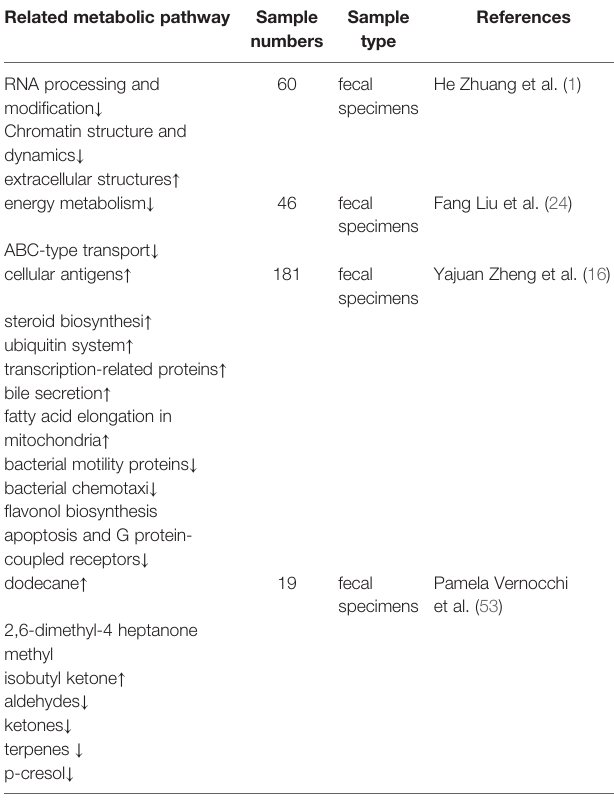
TABLE 2 | Metabolic characteristics of gut microbiota in lung